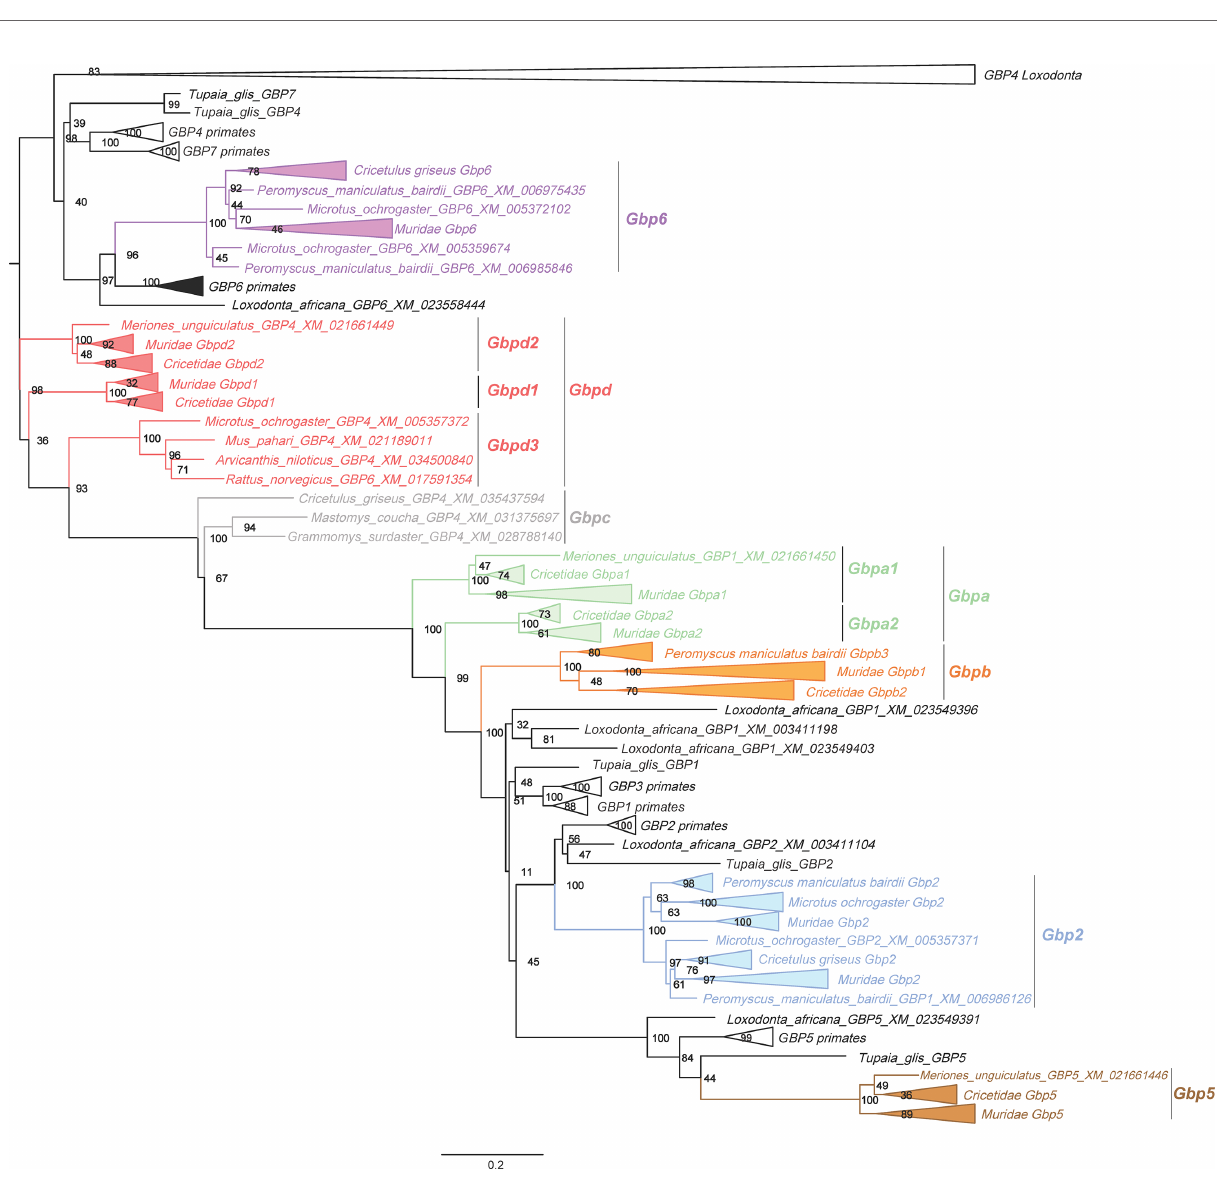
FIGURE 1 | Randomized Axelerated Maximum Likelihood (RAxML) tree of the Gbp genes in Muridae and Cricetidae. The tree was obtained using the RAxML method using 1000 rapid bootstrap and is represented with midpoint root. Numbers on branches are the ML bootstrap values. All new Gbpd groups are also present. In Supplementary Figure 1 , a full tree is depicted without collapsed nodes of Muridae and Cricetidae. Scale bar refers to the inferred amount of change per site along